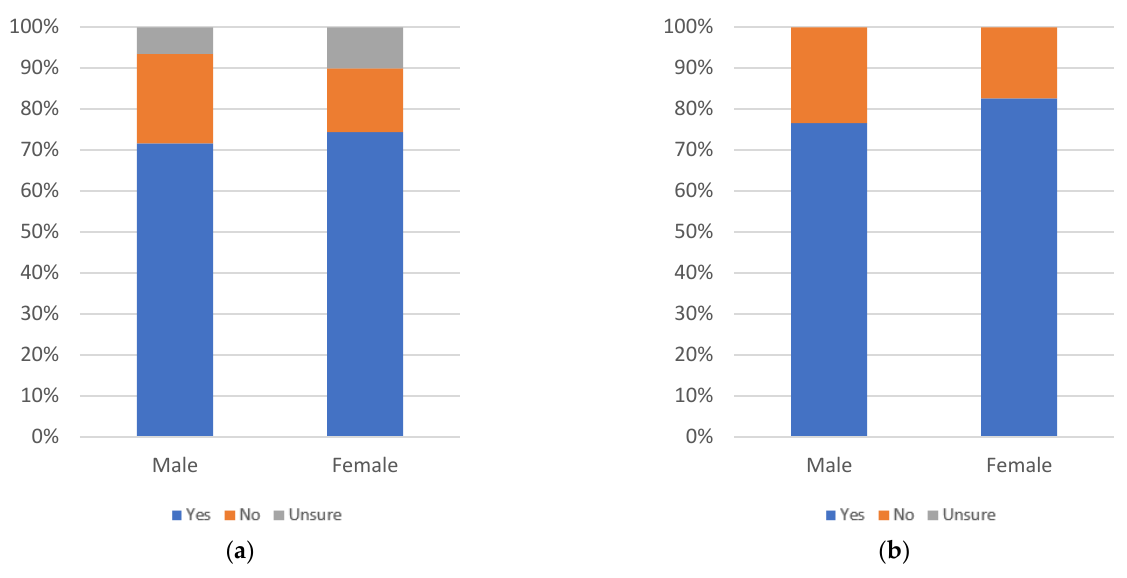
Figure 55. Label helpfulness, by gender: ( a ) with uncertain respondents (left) and ( b ) without uncertain respondents (right).